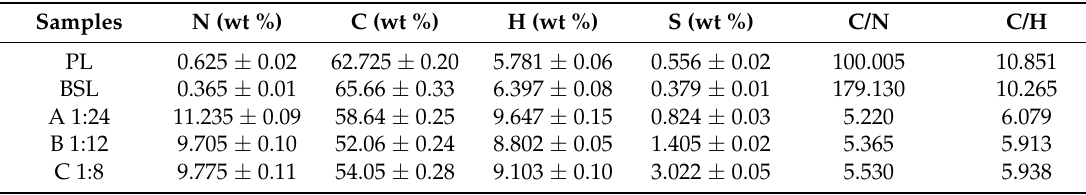
Table 2. Elemental composition of lignin fraction and gel.